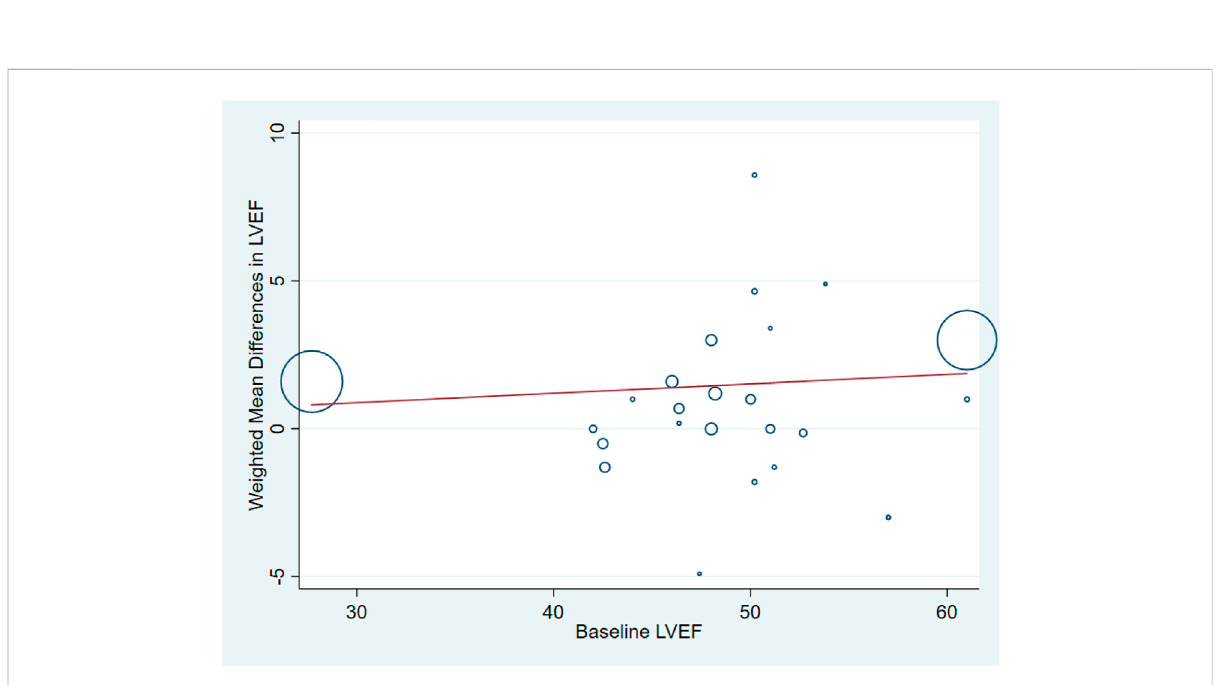
FIGURE 7 Meta-regression plots of the weighted mean difference in LVEF according to baseline LVEF ( p = 0.429). LVEF, left ventricular ejection fraction.